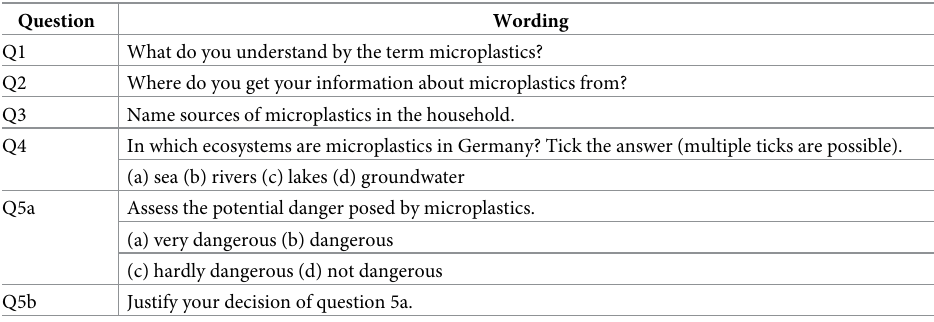
Table 2. Questionnaire questions.